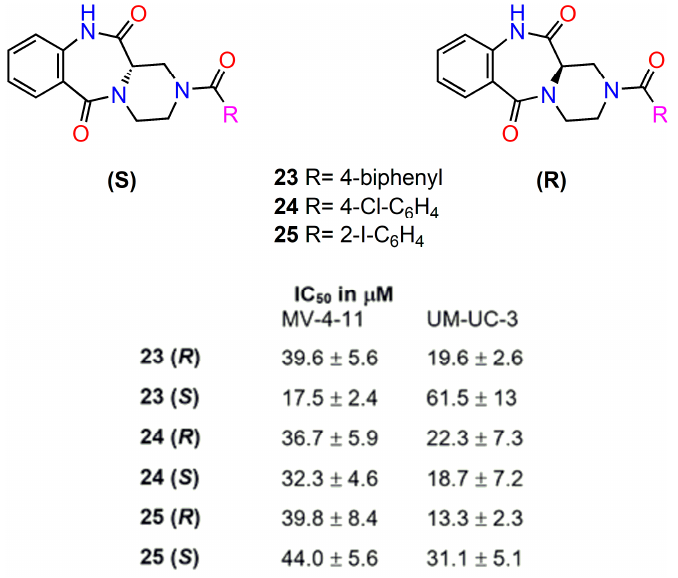
Figure 11. The structure and cytotoxic activity of the most active enantiomers of anthramycin analogues [92].